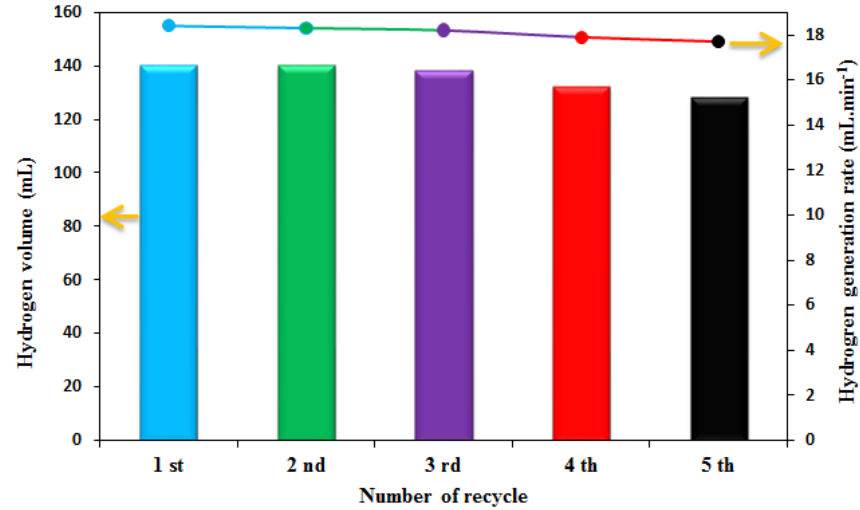
Fig. 9. The FS-NTs catalyst reusability for hydrolyzing NaBH